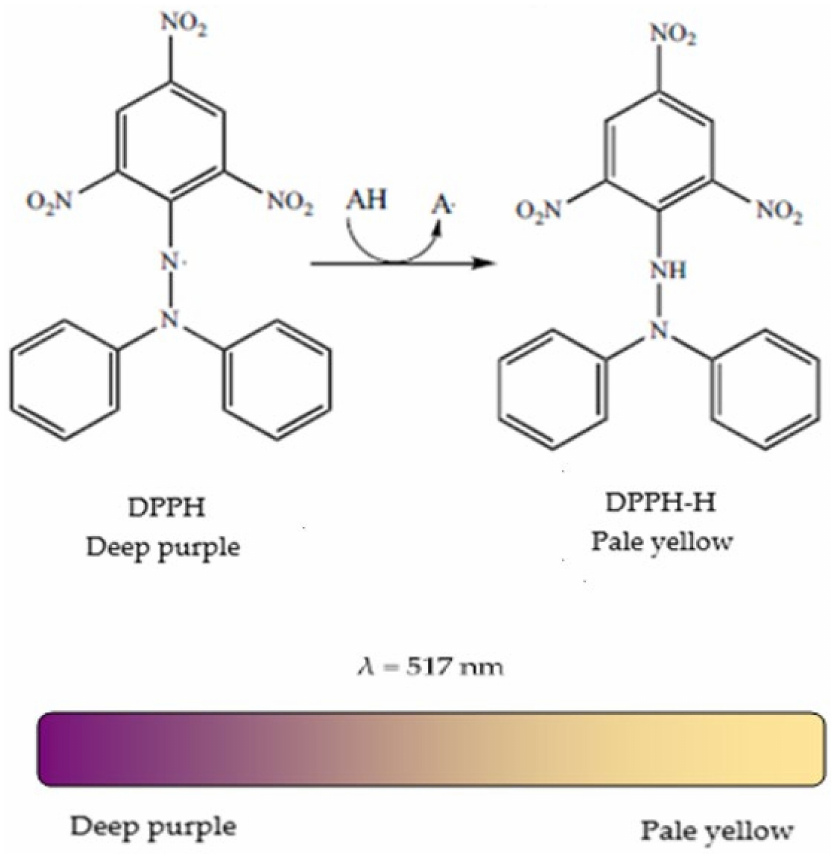
Figure 10. DPPH scavenging mechanisms by an antioxidant